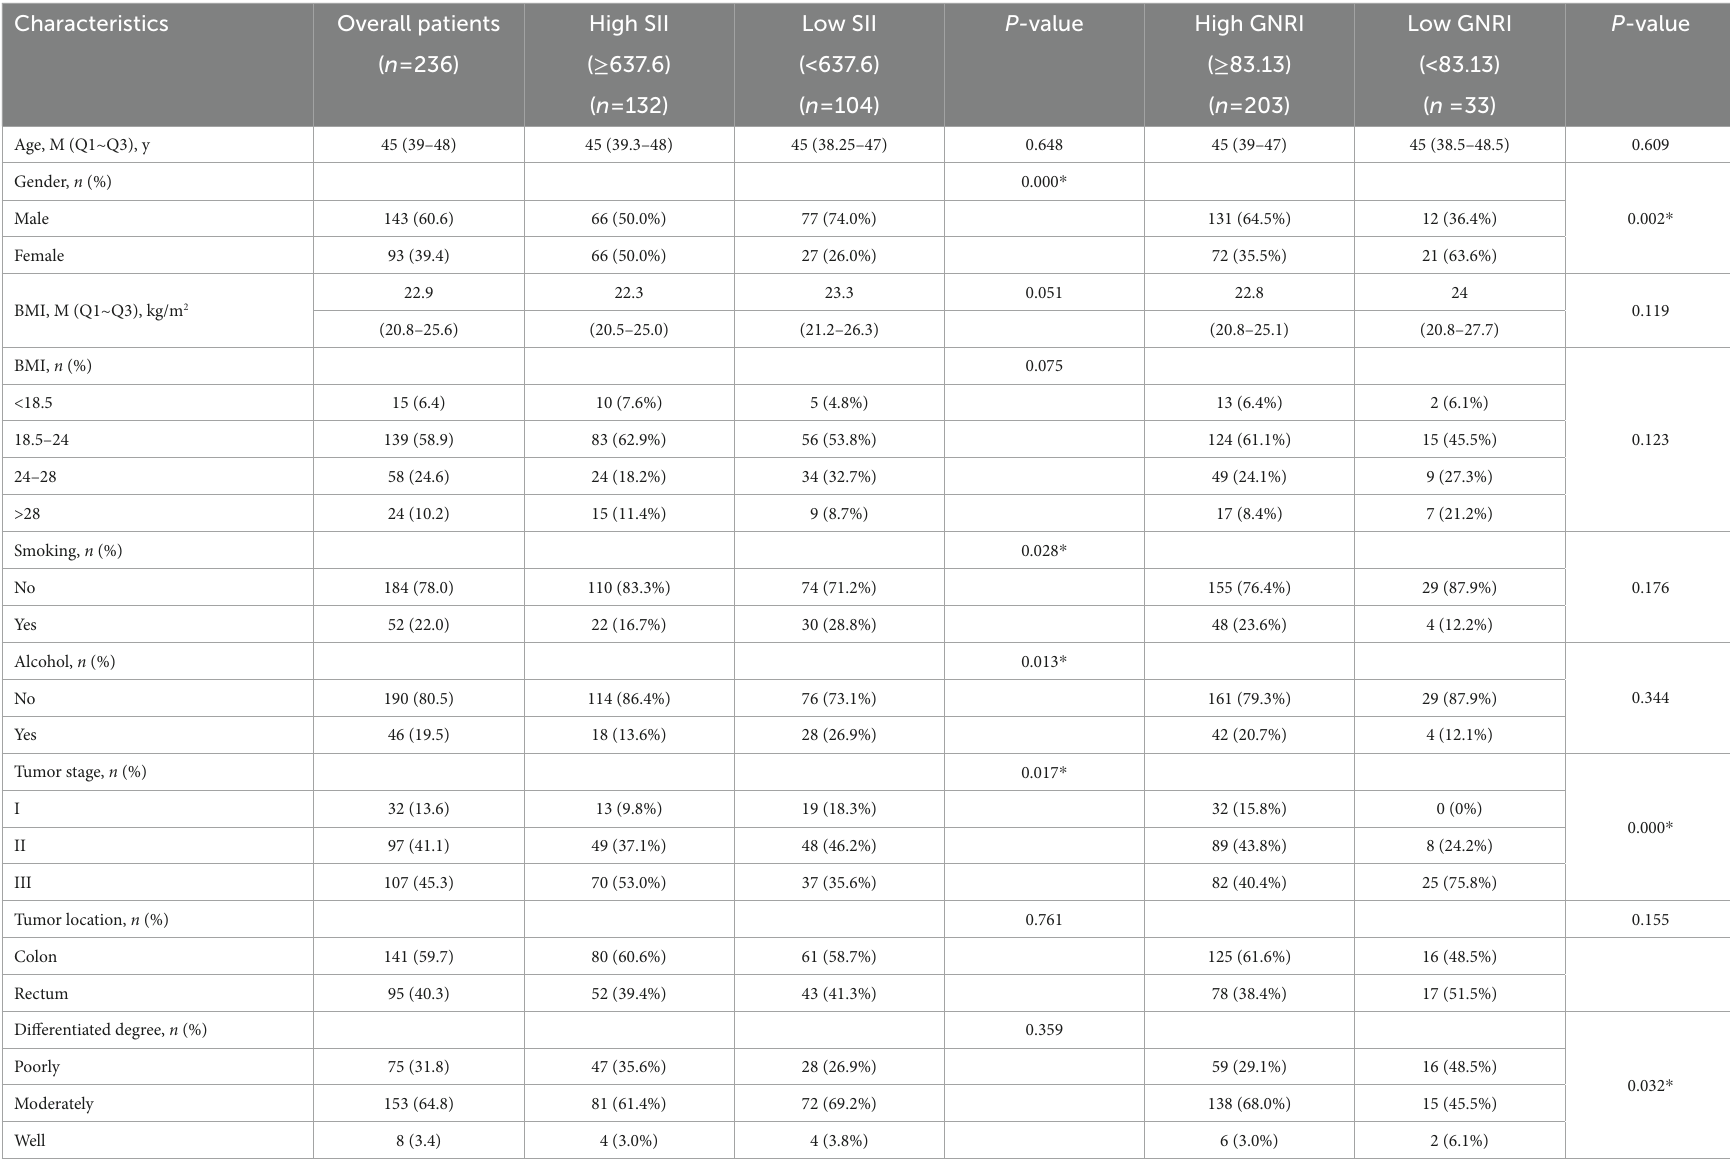
TABLE 1 Baseline characteristics of the study